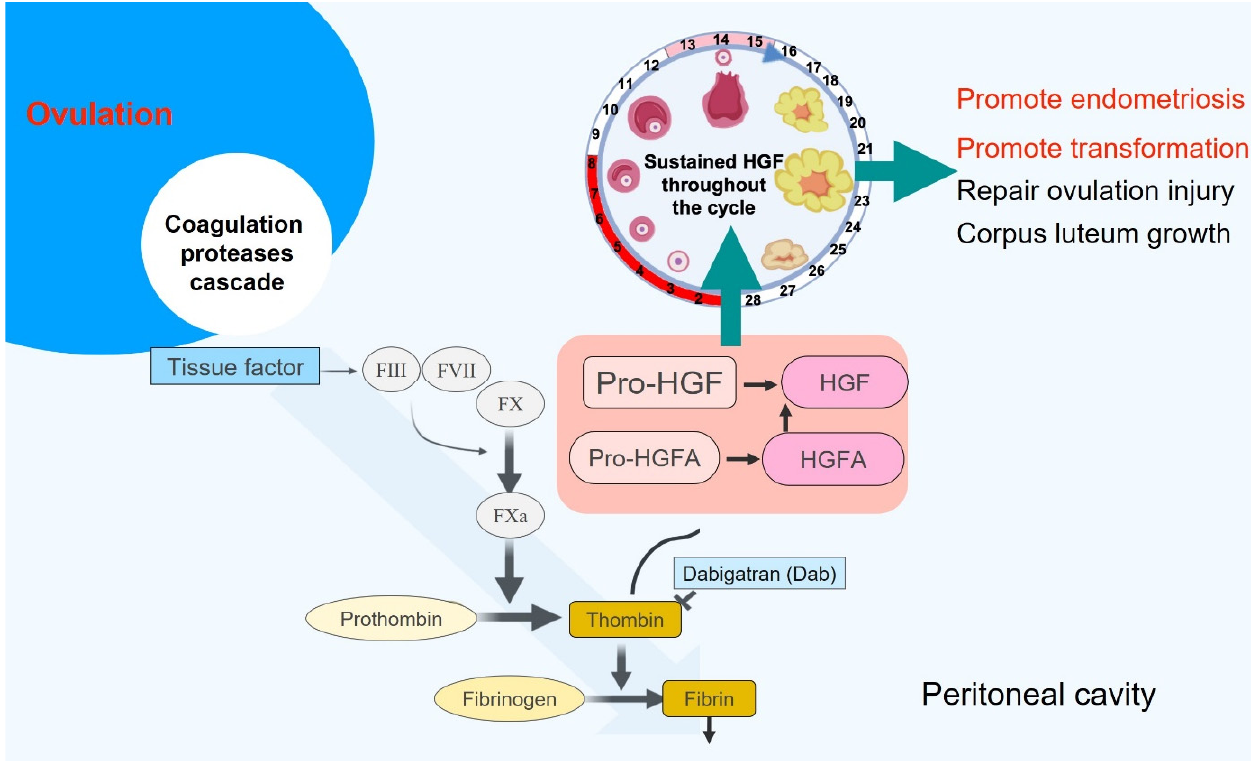
Figure 2. The coagulation cascade/HGF machinery in the follicular fluid exhibits prolonged growth- related activity that may promote the genesis of endometriosis. Follicular fluid (FF) exhibits pro- longed transformation and regeneration activities before and after mixing with the peritoneal